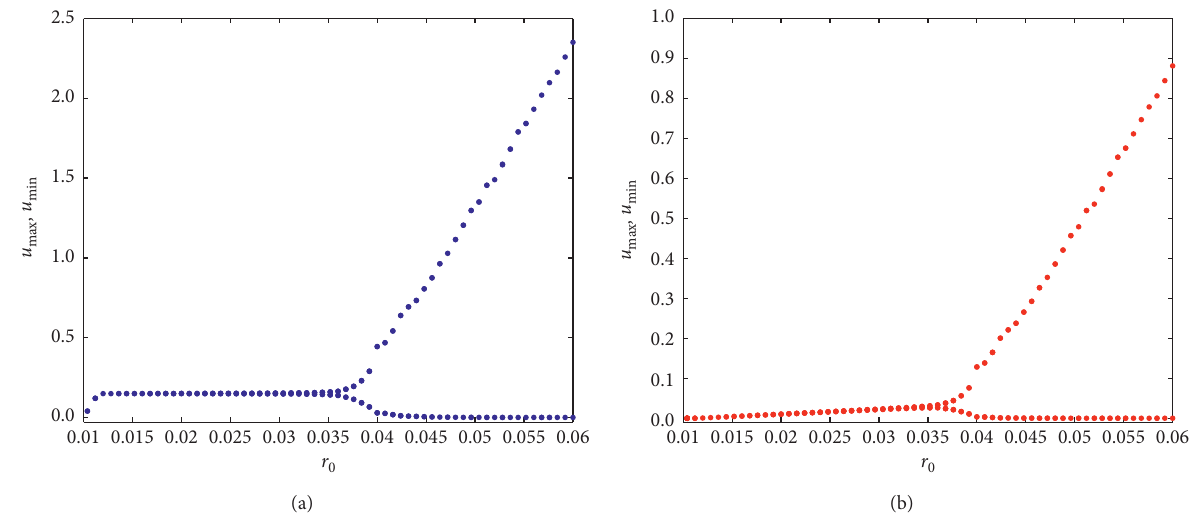
Figure 9: Bifurcation diagram with respect to birth rate of prey species r of the predator-prey system (19) with Beddington–DeAngelis-type 0 � 0 . 01, c � 0 . 01, α � 0 . 9, β � 0 . 5, δ � 0 . 05, θ � 0 . 4, and ξ � 0 . response function. Other parameter values are specified as δ 1 2 � 0 . 01, c � 0 . 01, α � 0 . 9, the other parameter values are δ 1 � 0 . 05, and ξ � 0 . 30. The bifurcating β � 0 . 5, θ � 0 . 4, δ 2 parameter r varied from 0 to 0.04 and is plotted r along the 0 0 x − axis and equilibrium prey (left panel in Figure 13) and predator (right panel in Figure 13) density along the y − axis. Black line represents the stable branch of the trivial equi- librium point E 0 ( 0 , 0 ) , blue-dotted curve represents the stable branch of the boundary equilibrium point E 1 ( 􏽢 u, 0 ) , and the green line represents the unstable branch of the boundary equilibrium point E 1 ( 􏽢 u, 0 ) . Red curve indicates E ∗ ( 􏽢 u ∗ , 􏽢 v ∗ ) , and the magenta line indicates the unstable